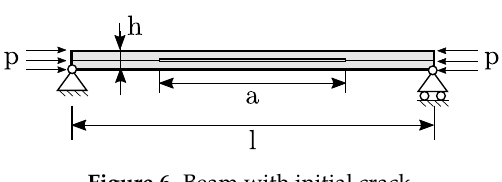
Figure 6. Beam with initial crack.